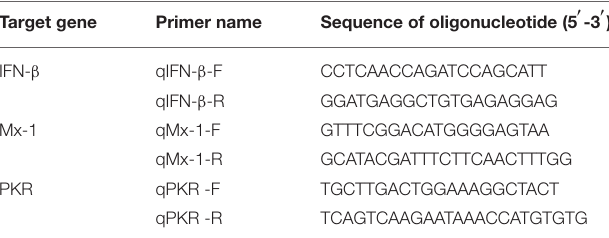
TABLE 2 | Primers used for Quantitative real-time